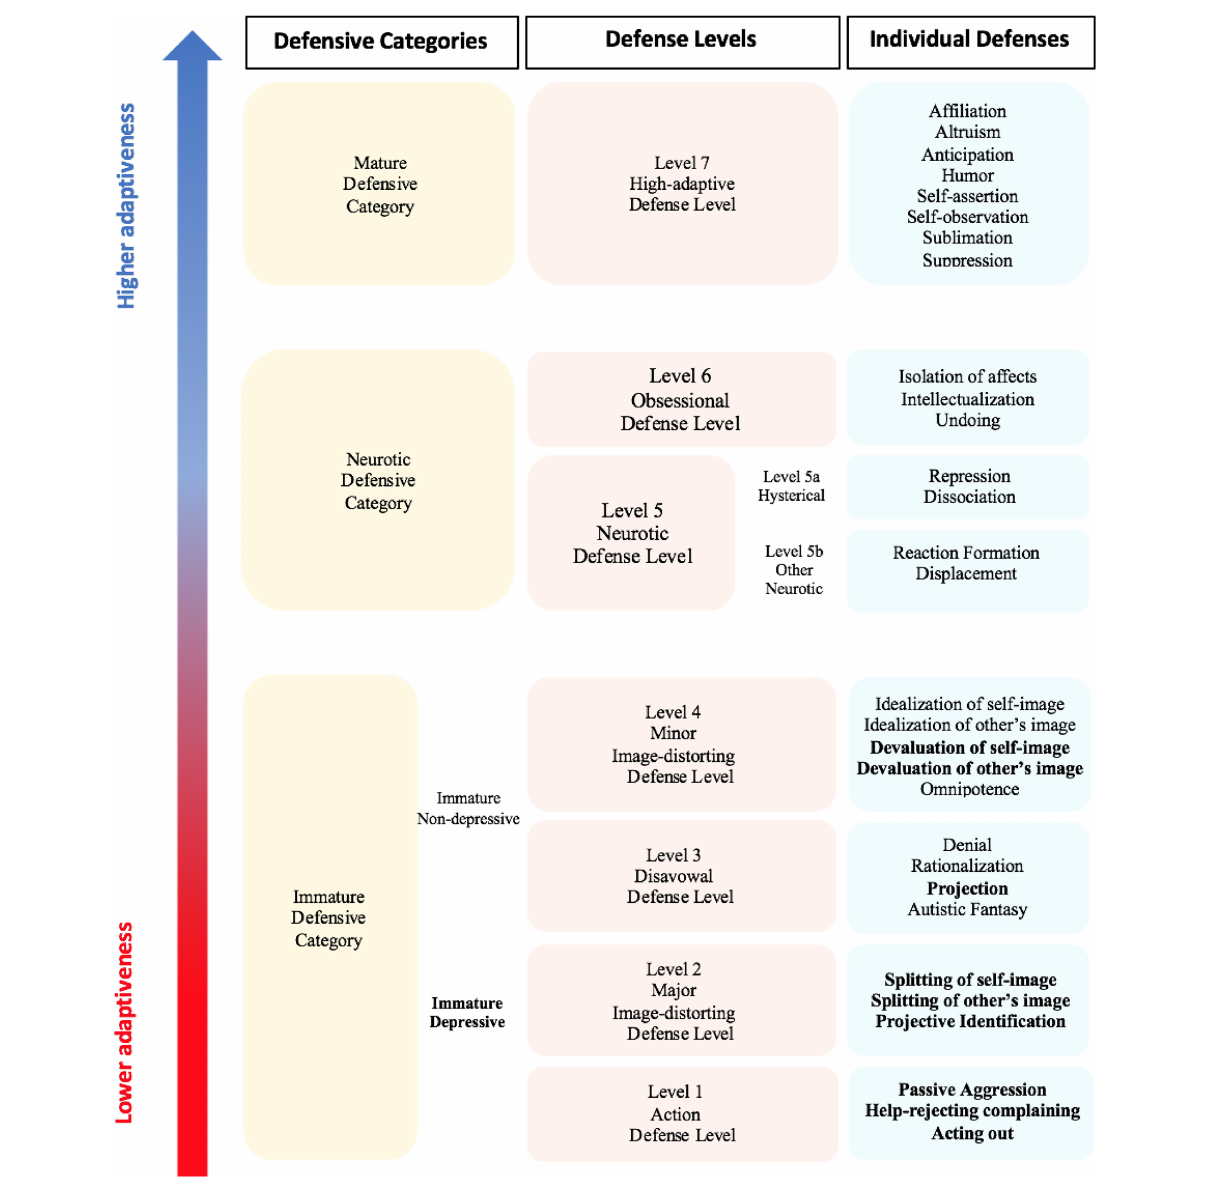
FIGURE 1 | The DMRS hierarchical organization of defensive categories, defense levels and individual defenses. Table adapted from Perry and Bond (2012), Table 1 . So-called depressive defenses are in